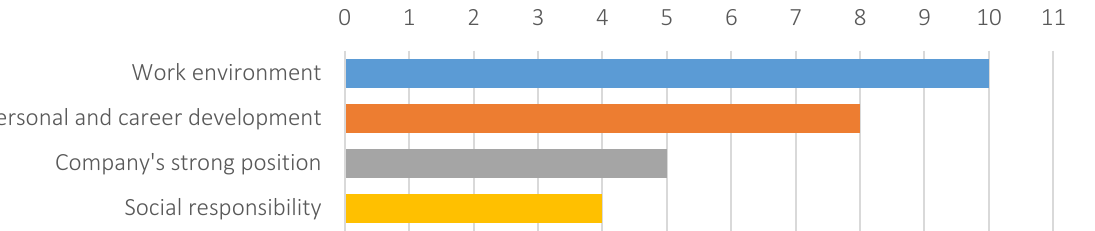
00.511.522.5 Figure 2a. Internal marketing and market position of the organization/executives’ perceptions Figure 2b. Internal marketing and market position of the organization/coding